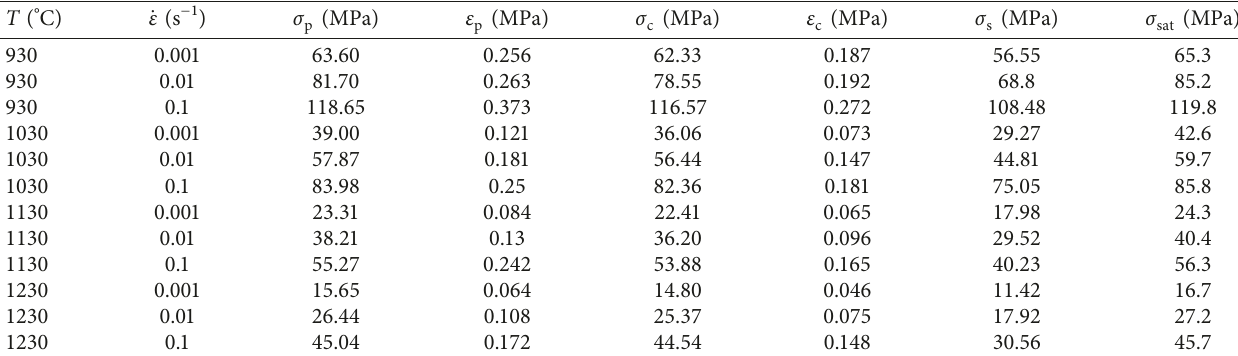
Figure 5: (a) Schematic plot showing the peak stress-strain, critical stress-strain, steady-state stress, and saturated stress on the true stress- strain curve. (b) Work-hardening rate with respect to stress: determination of σ Table 1: Values of characteristic strains and stresses at different deformation